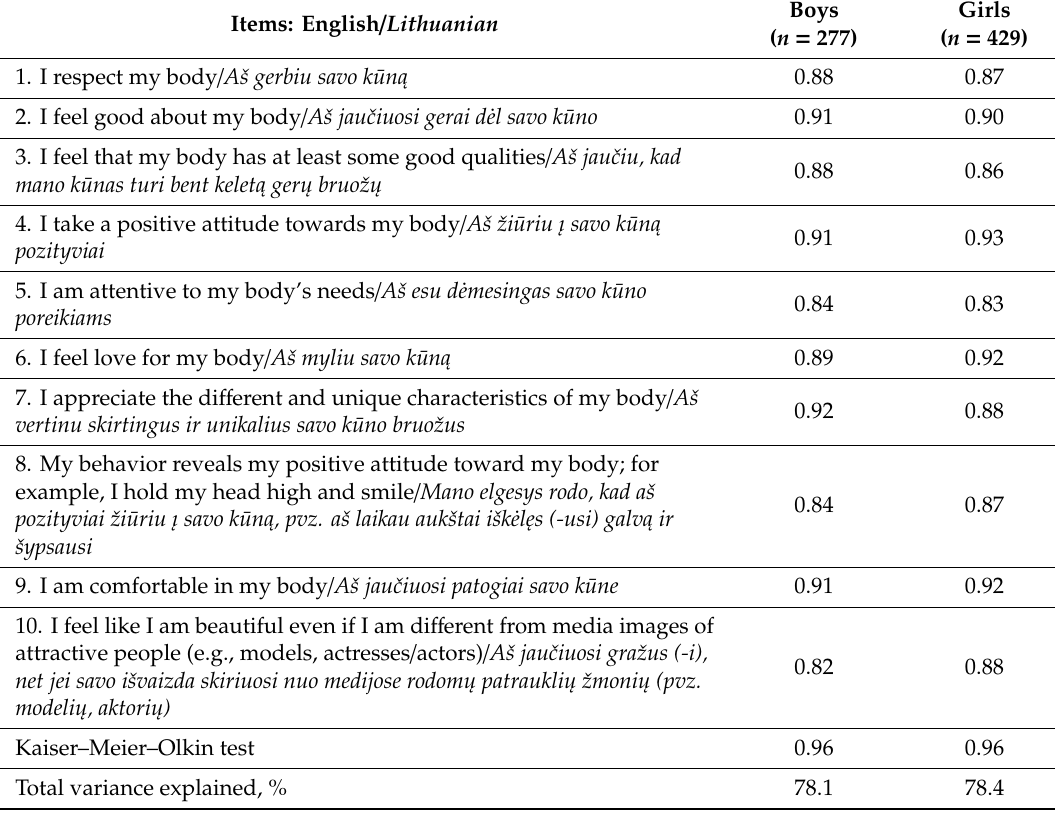
Table 2. Body Appreciation Scale-2 items in English and Lithuanian and associated item-factor loadings for adolescents from the first split-half subsample ( n =